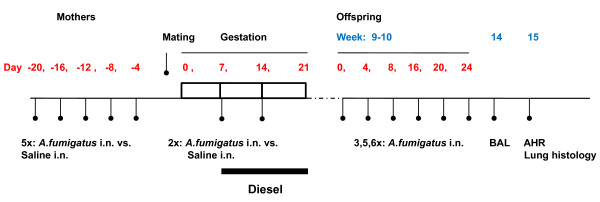
Experimental protocol. Adult females received 5 dosages of A. fumigatus or saline, 20, 16, 12, 8, and 4 days prior to mating. During the second and third weeks of pregnancy, mothers received diesel exhaust particle exposure Monday through Friday plus A. fumigatus or saline on days 7 and 14. AHR: Airway hyperreactivity BAL: Bronchoalveolar lavage i.n: intranasal 3×: 3 doses of A. fumigatus 5×: 5 doses of A. fumigatus 6×: 6 doses of A. fumigatus